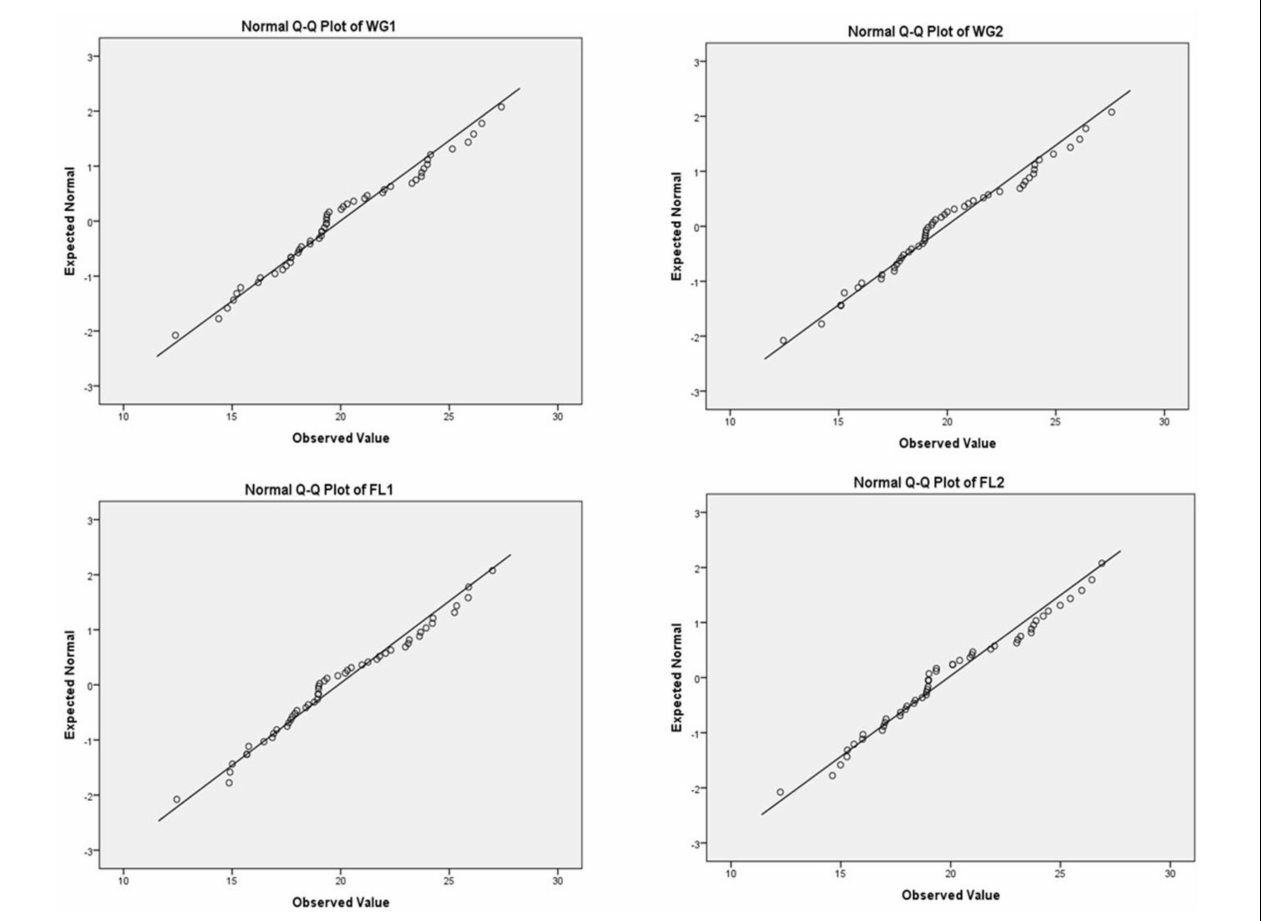
FIGURE 5 | Normal Q-Q plots of WG1, WG2, FL1, and